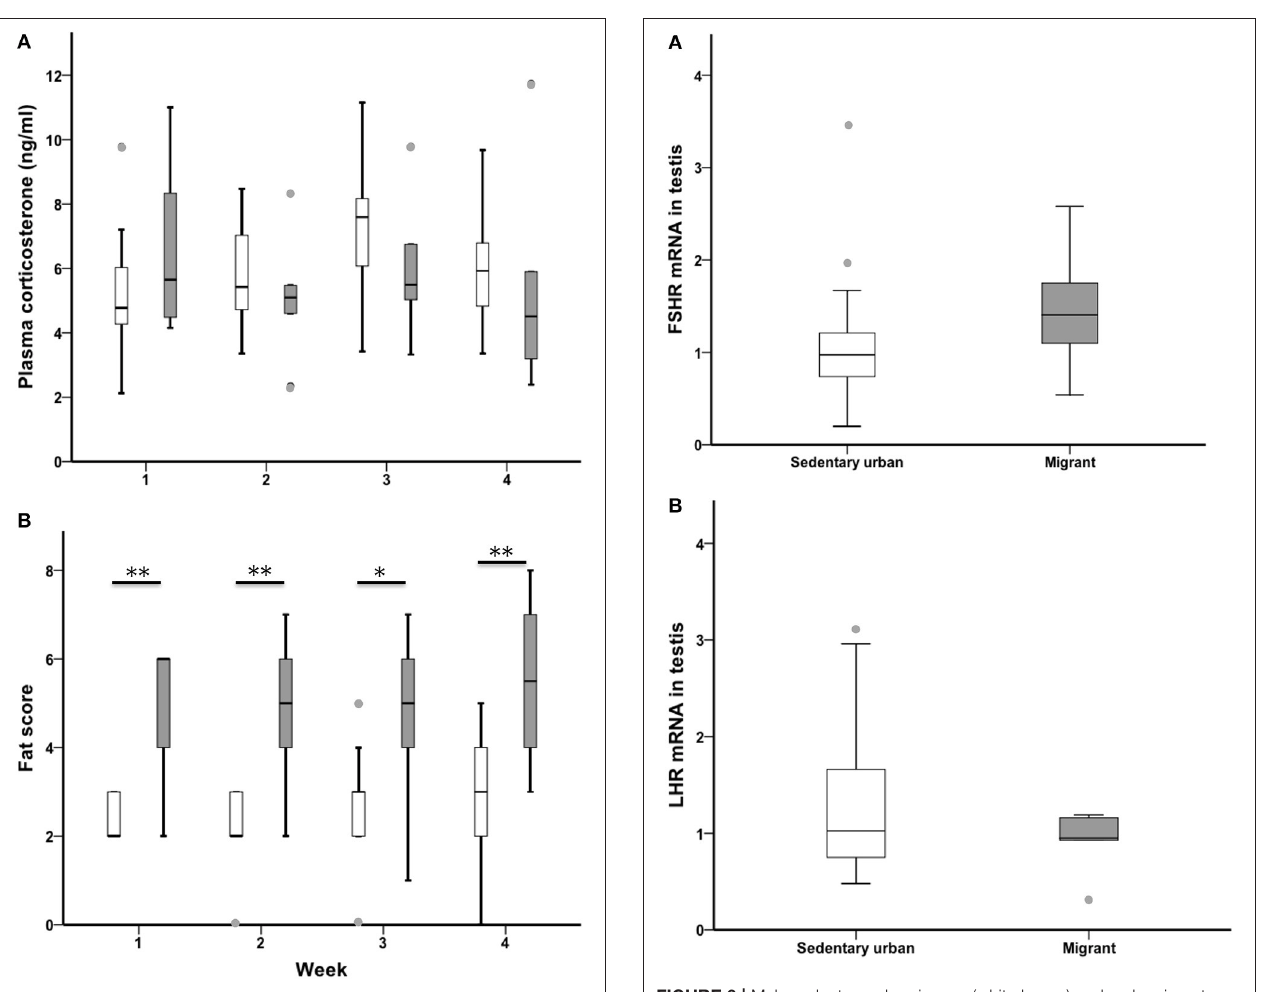
juncos (GR: U = 34.00, n urban = 18, n migrant = 6, p = 0.182; MR: U = 37.00, n urban = 18, n migrant = 6, p = 0.257; Figure 7